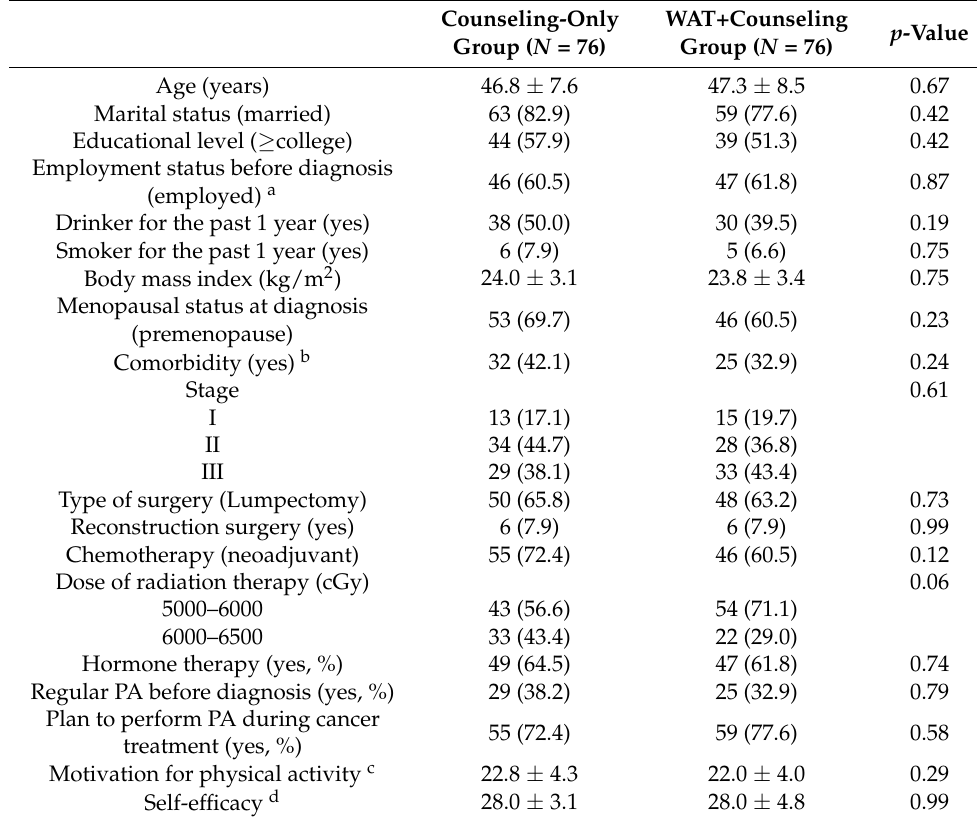
Table 1. Baseline characteristics.